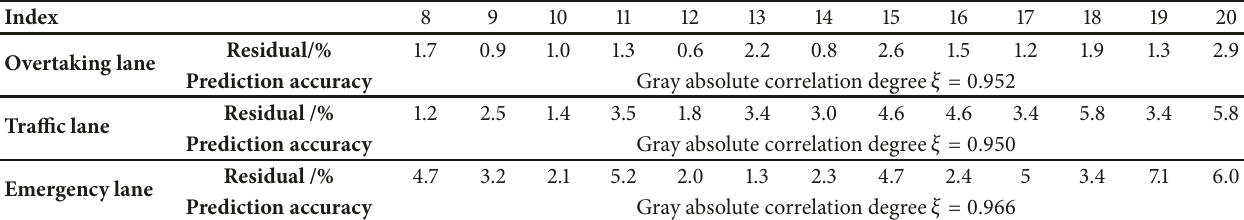
Table 4: Accuracy test results of lane smoothness.